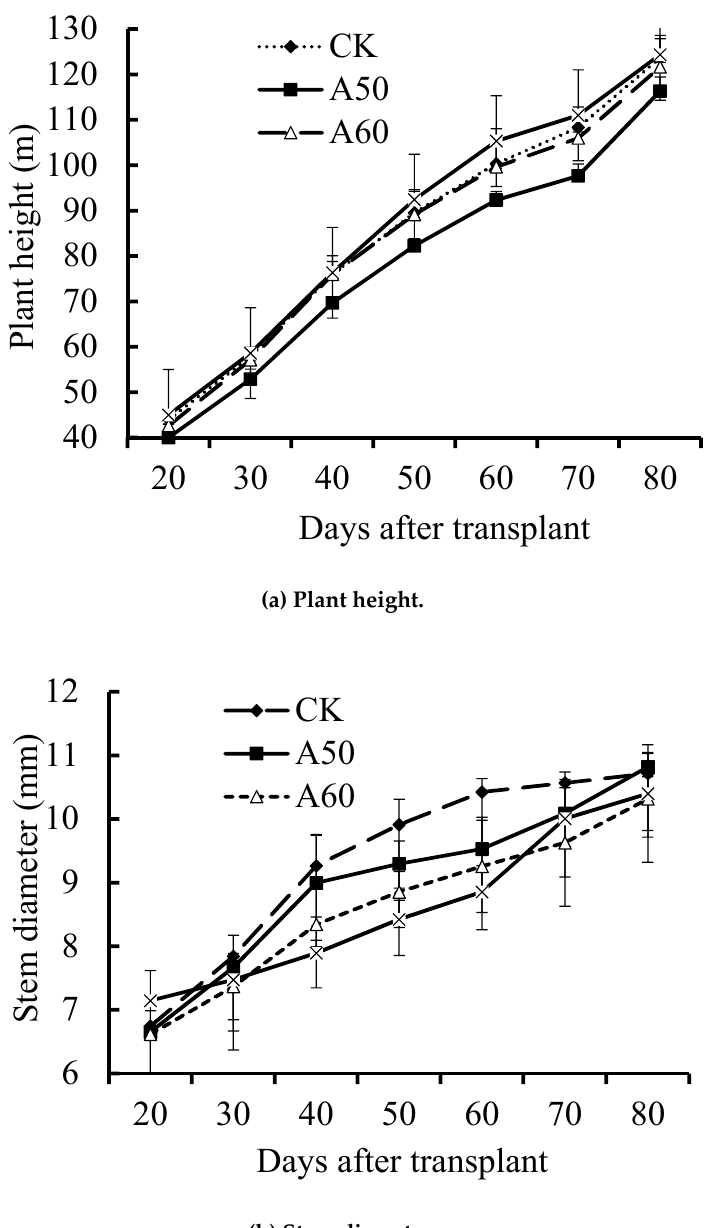
Figure 1. Plant height and stem diameter. CK = control.